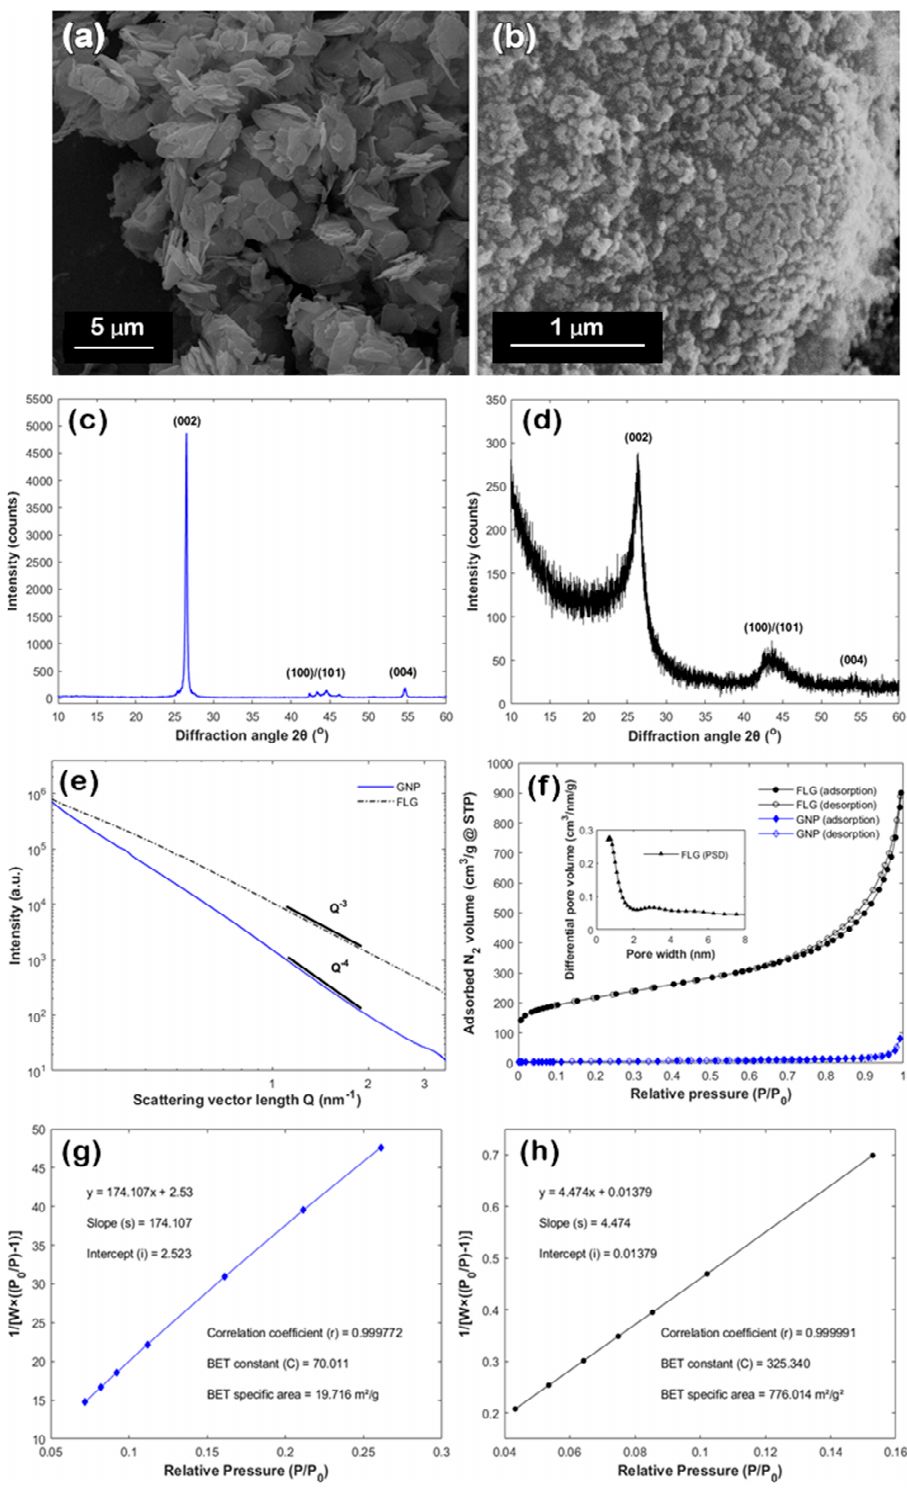
Figure 2. SEM images of the plasma-derived ( a ) GNP and ( b ) FLG powders, X-ray diffractograms for ( c ) GNP and ( d ) FLG, ( e ) SAXS curves, ( f ) N 2 adsorption/desorption isotherms recorded at 77 K and linear multi-point BET plots for ( g ) GNP and ( h ) FLG.